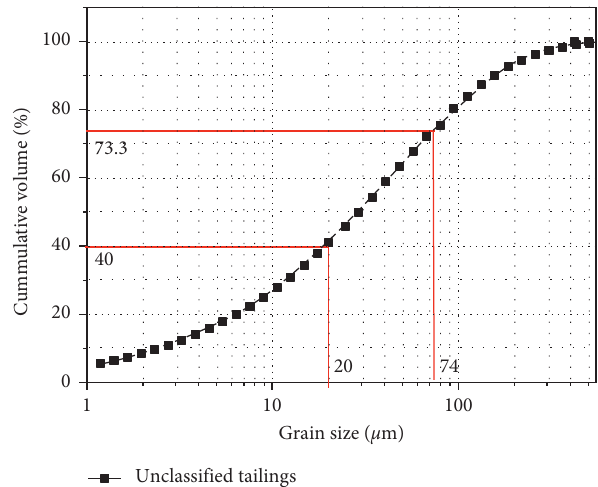
Figure 3: The particle size distribution of unclassified